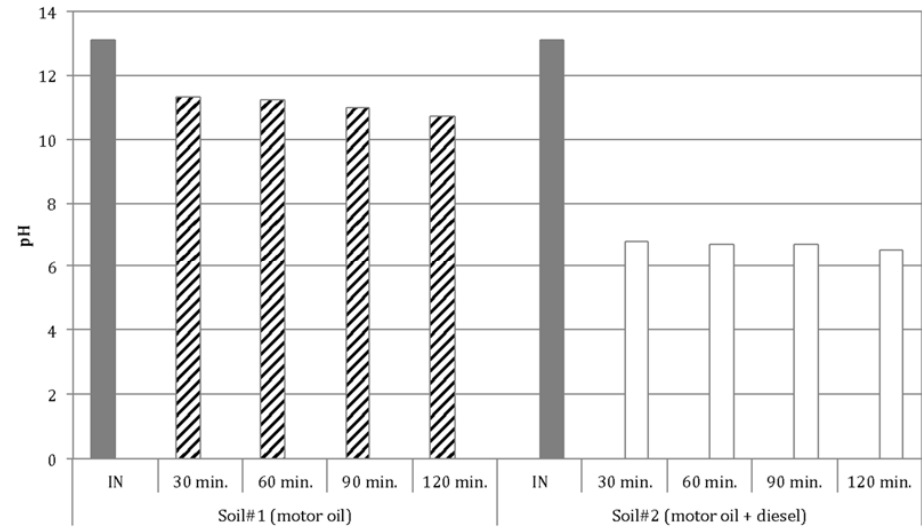
Figure 4. Soils’ pH values after the wet oxidation ( WO) treatment.